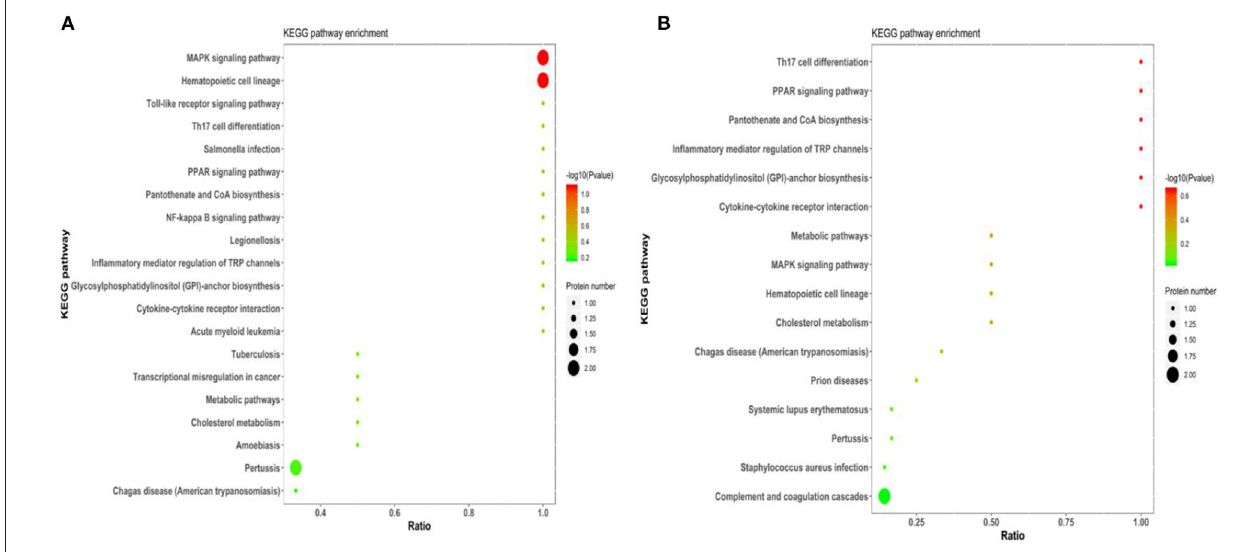
FIGURE 6 | KEGG pathway of subclinical VE deficiency-related proteins enrichment results. Abscissa is ratio, ordinate is each KEGG pathway entry, color represents enrichment [–log10 ( p -value)], and circle size represents protein number. (A) The enrichment results of all differential proteins. (B) The enrichment results of downregulated differential proteins.